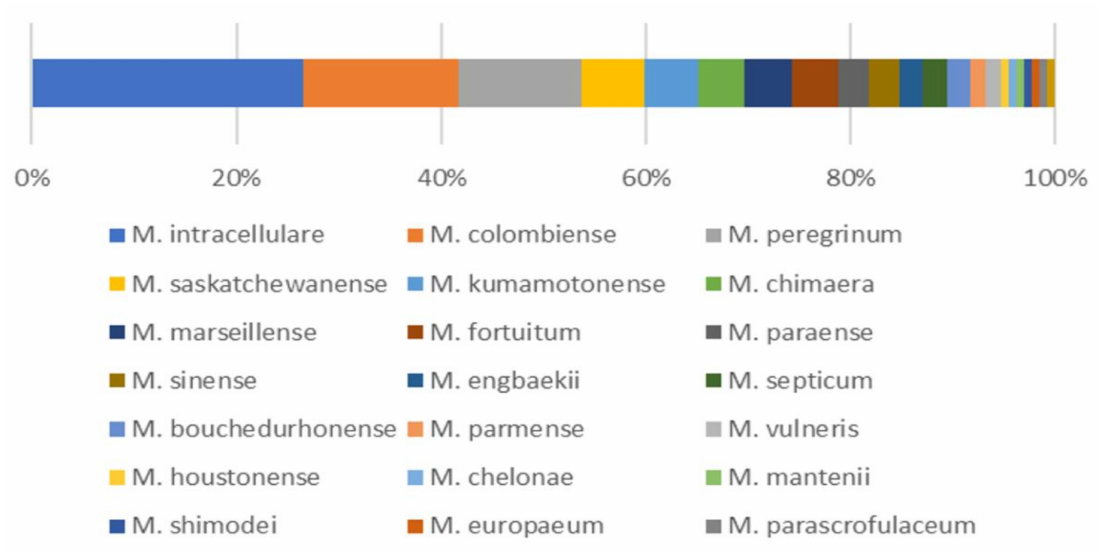
Figure 1. Distribution of non-tuberculous mycobacterial species isolated from South Korean